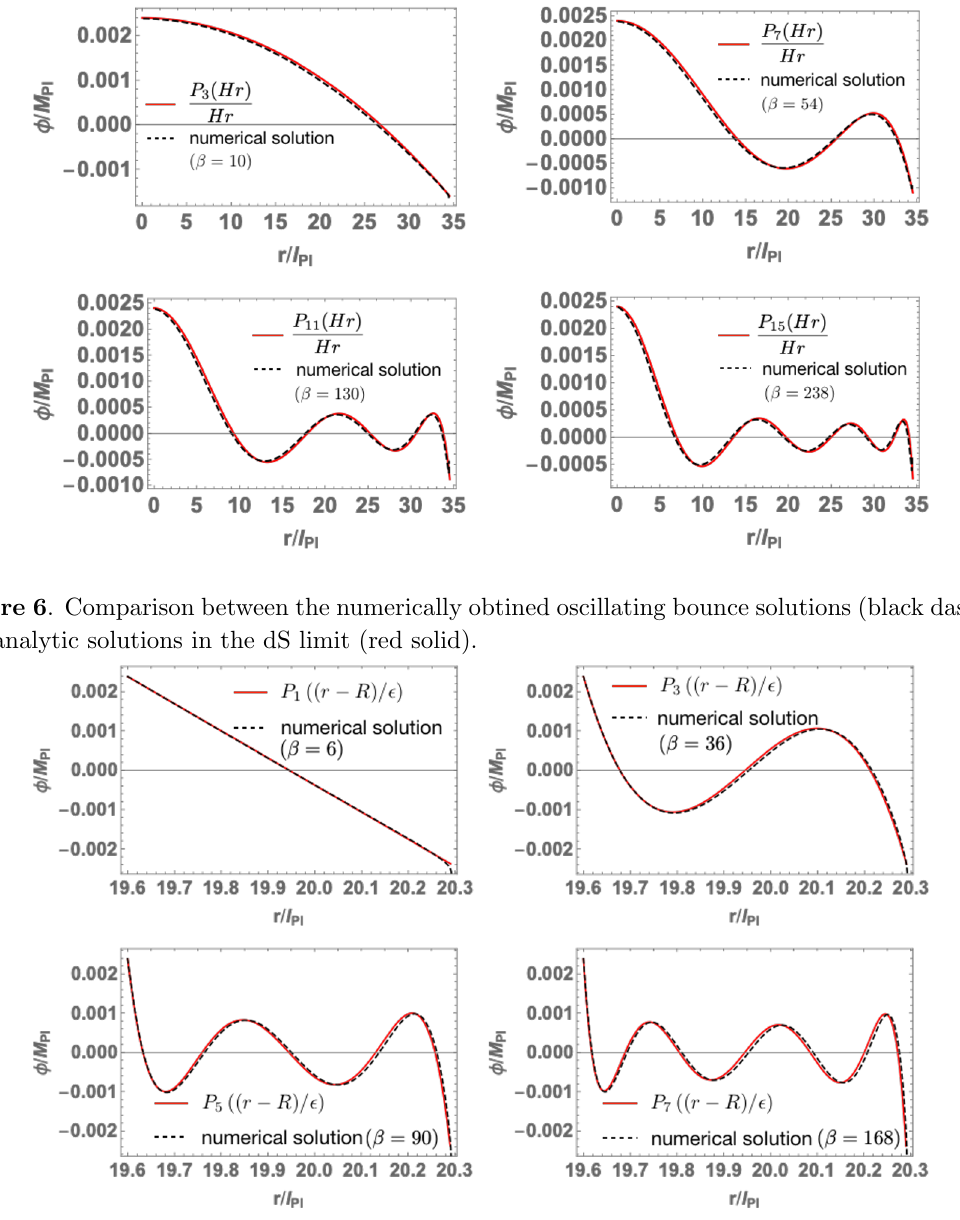
Figure 7 . Comparison between the numerically obtined oscillating bounce solutions (black dashed) and analytic solutions in the Nariai limit (red solid).